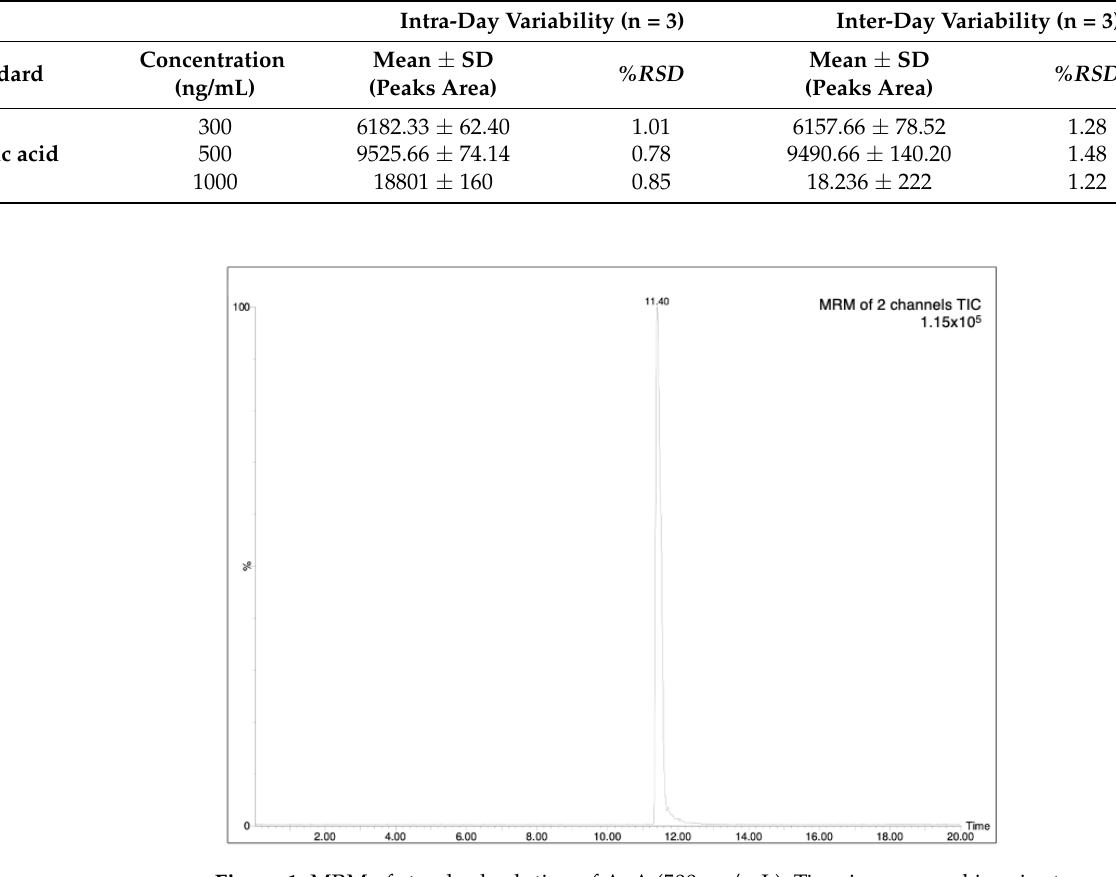
Figure 1. MRM of standard solution of AzA (500 ng/mL), Time is expressed in minutes.